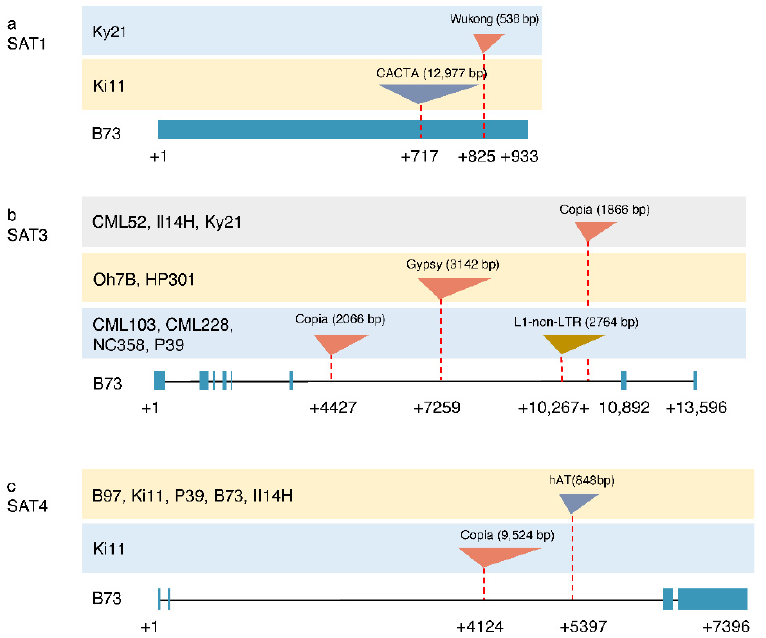
Figure 4. Transposon insertions in SAT1, SAT2 and SAT4 for nested association mapping (NAM) founders. ( a ) Transposon insertion in the SAT1 gene. ( b ) Transposon insertion in the SAT3 gene. ( c ) Transposon insertion in the SAT4 gene. The bottom line is the B73 reference, including exons with blue boxes and introns with black lines. The transposon type is colored by different triangles. SAT2 is skipped given no transposon insertion. Ky21, Ki11, CML52, Il14H, Oh7B, HP301, CML103, CML228, NC358, P39 and B97 represent the maize inbred lines of NAM founders.